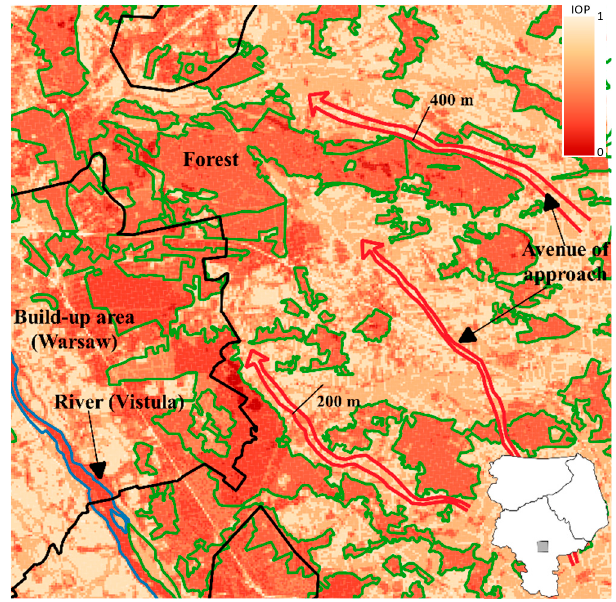
Figure 11 . Part of a passability map generated using a primary field of 100 × 100 m with avenues of approach and the most significant elements of land cover.